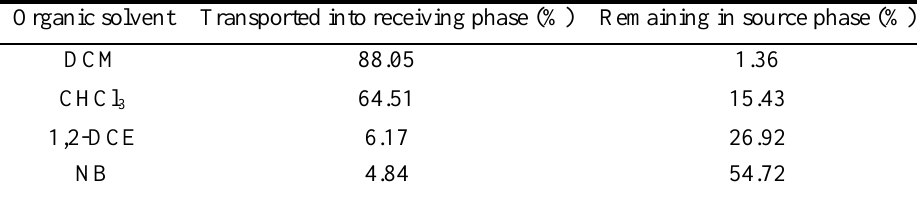
Table 1. Effect of the organic solvent on Ag + cation transport a . Organic